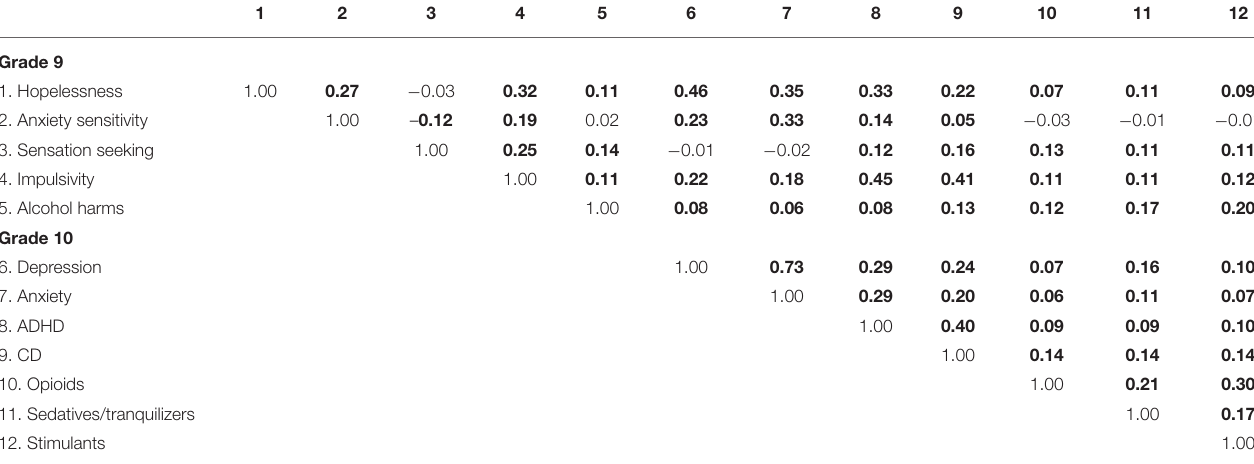
† represents marginal significance at